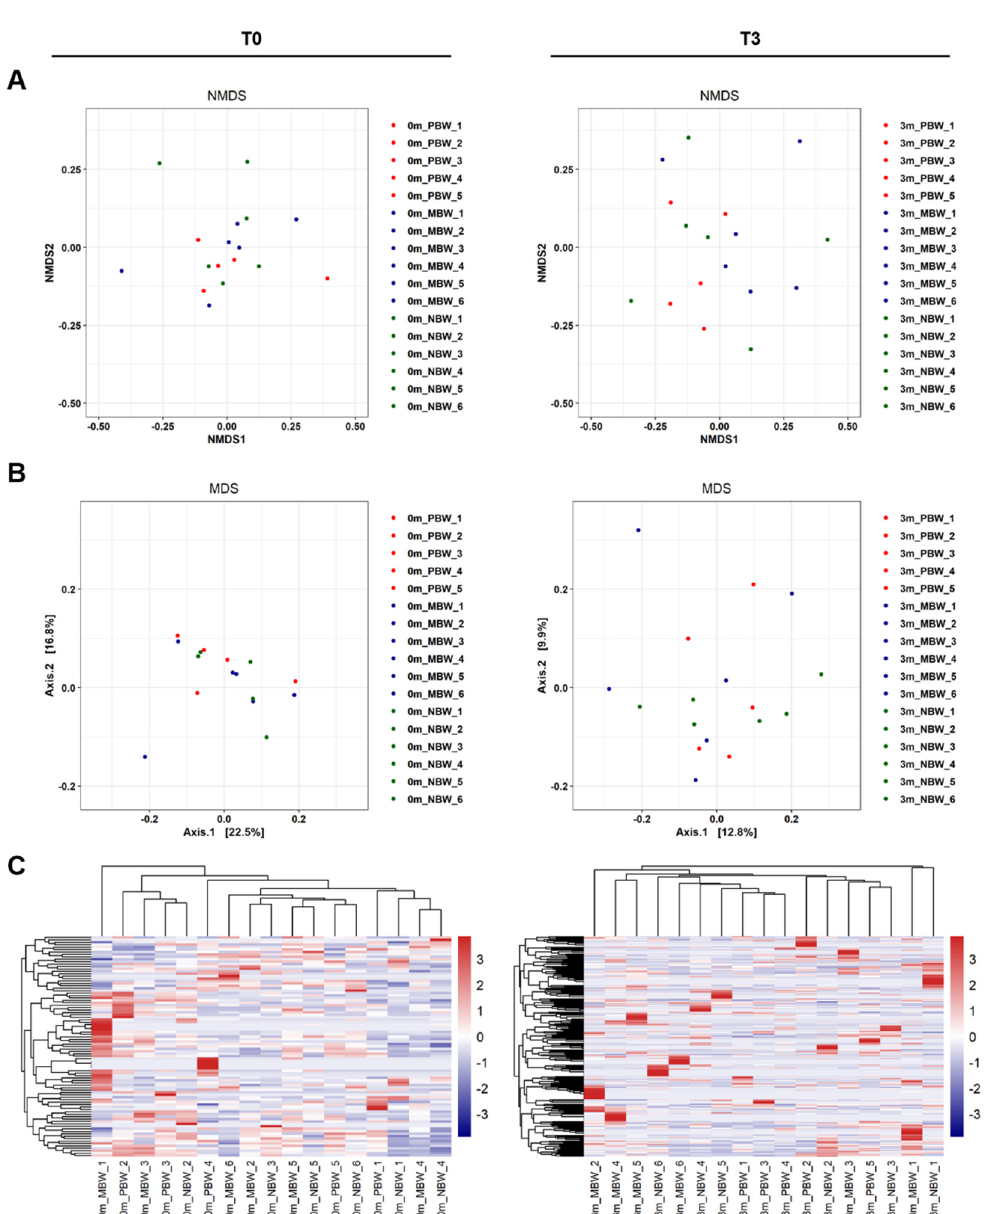
Figure 5. The β -diversity comparison of the gut microbiome of the PBW, MBW, and NBW groups. ( A ) NMDS plots showing differences in the gut microbiome before (T0, ( left )) and after (T3, ( right )) the gut microbiome replacement in the PBW, MBW, and NBW groups based on Bray-Curtis distances using OTUs. ( B ) MDS plots showing difference in the gut microbiome before (T0, ( left )) and after (T3, ( right )) the replacement in the PBW, MBW, and NBW groups based on Bray-Curtis distances using OTUs. ( C ) Heatmaps of the microbial composition of the PBW, MBW, and NBW groups before (T0, ( left )) and after (T3, ( right )) the replacement based on Bray-Curtis distance matrix measured at the species level.